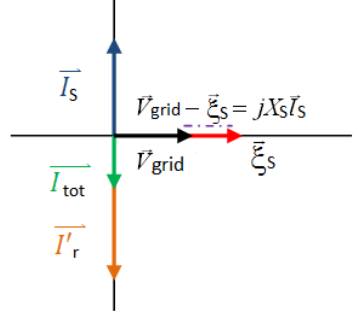
Figure 4. Desired positions of the space phasors during a voltage